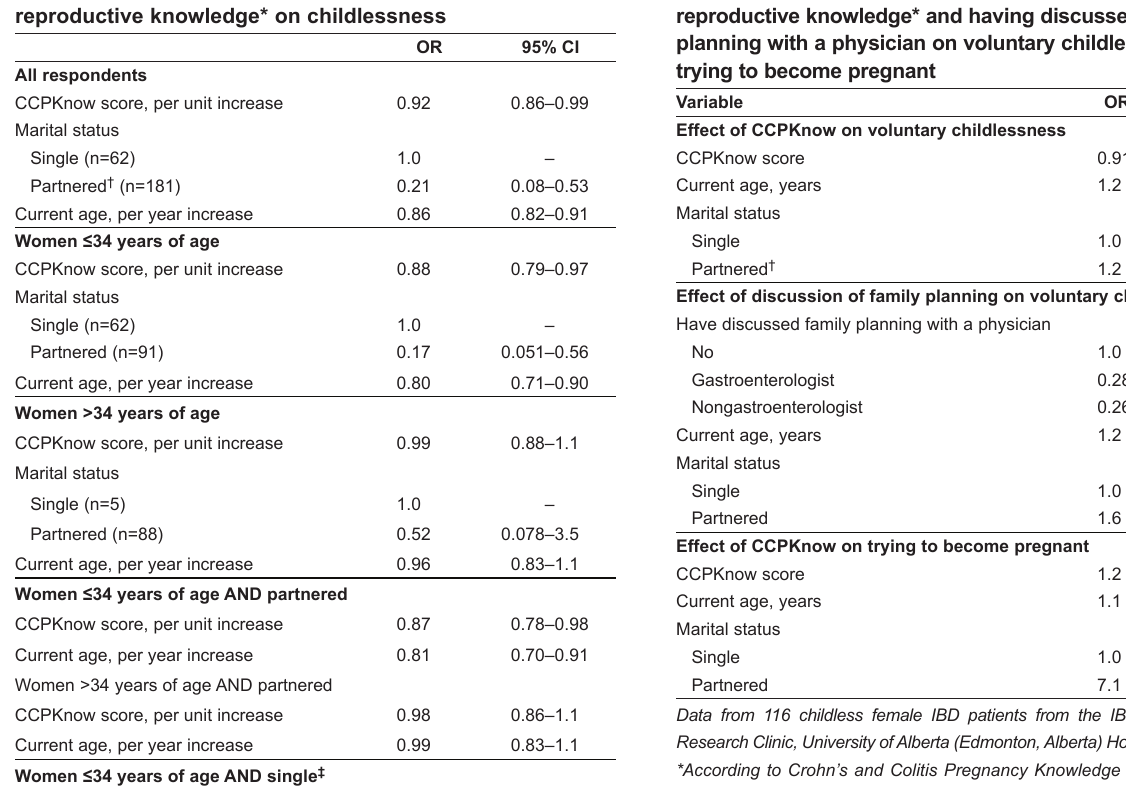
TABLE 3 Multivariable logistic regression model for estimating the effect of inflammatory bowel disease (IBD)-specific